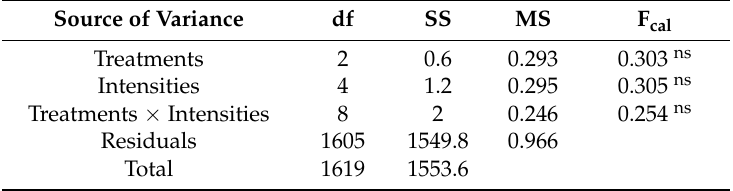
Table A4. Analysis of variance (ANOVA) of the means of the real and predicted values by ANN and regressions with Model 5 at sample intensities of six to two trees per diameter class in scenario (b).